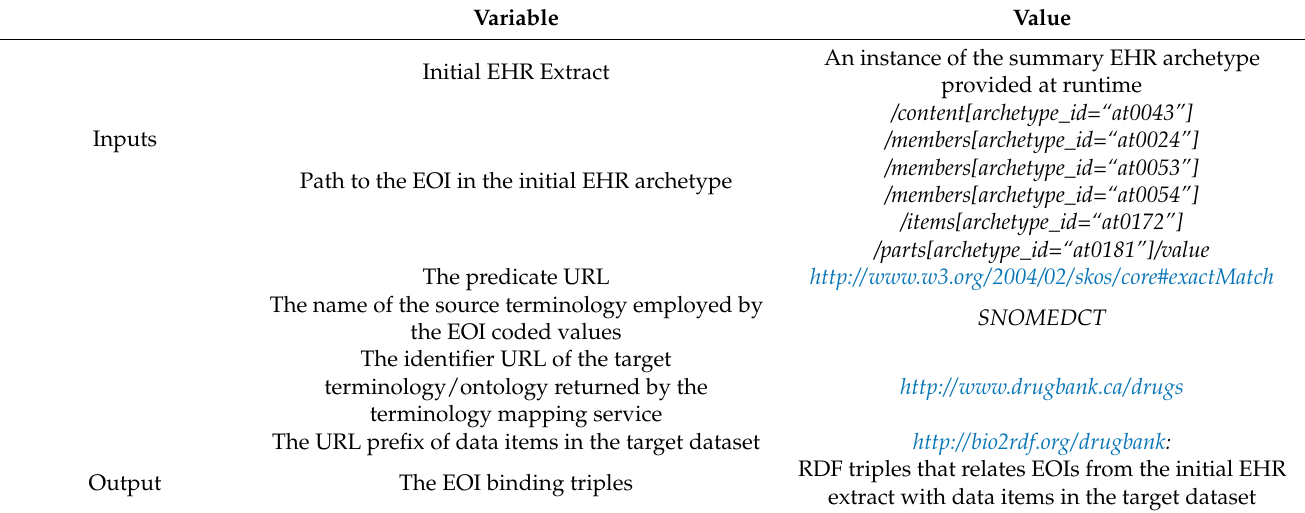
Figure 10. On the left, a LinkEHR visualization of the initial EHR archetype CEN-EN13606-COMPOSITION. HistoriaClinicaResumida.v1 . On the right, two views of the initial EHR extract presented in HTML. The EOIs’ active episode of patients’ diseases ( EOI 1 ) and patients’ active medication ( EOI 2 ) and their coded values are highlighted on both the initial EHR archetype and the initial EHR extract. Table 1. Inputs and output of the automatic procedure to build the EOI binding triples for the drug–drug interactions’ EHR